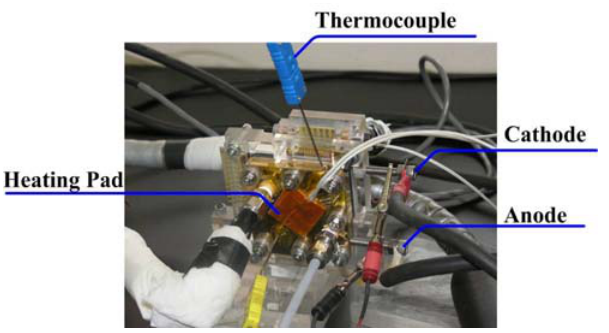
Figure 12. Fuel cell testing system.